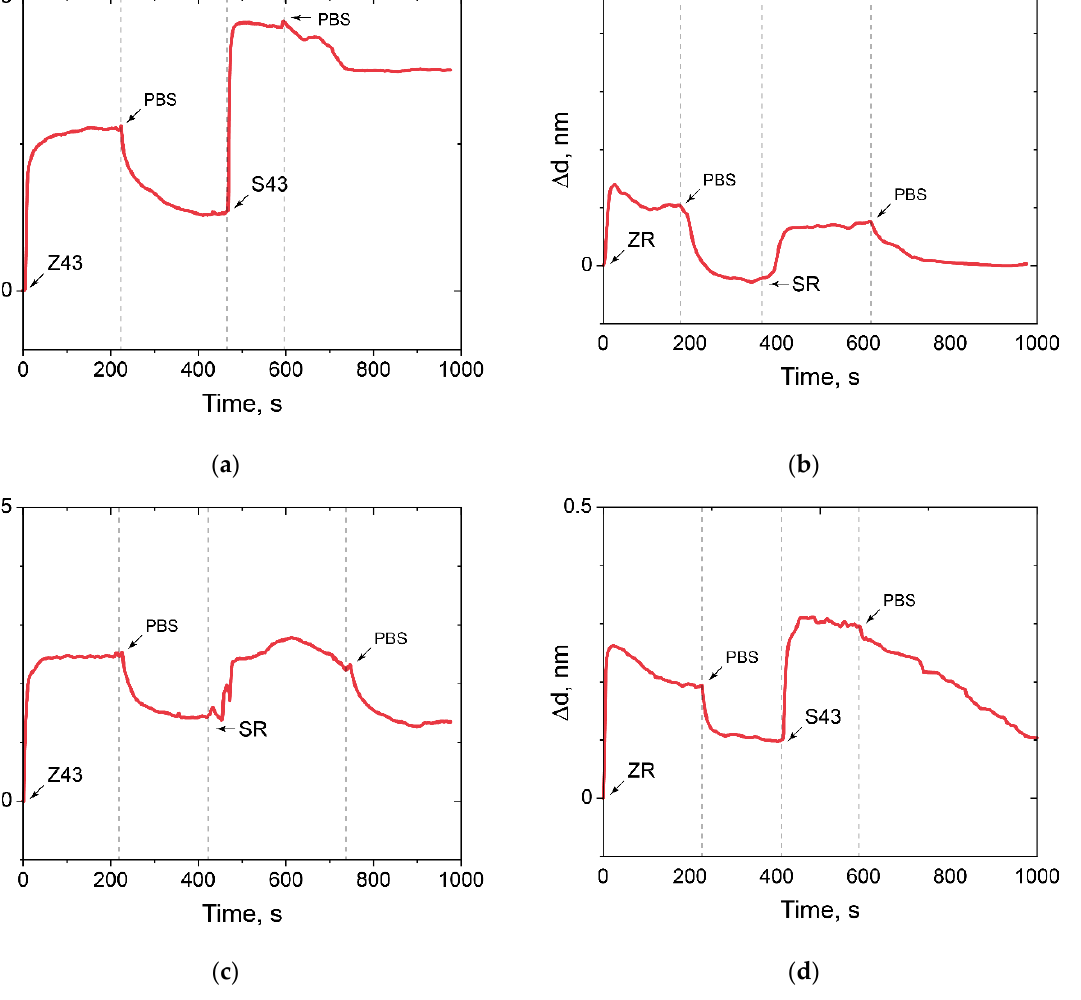
Figure 10. The change in the adlayer thickness upon positive and negative control of oligonucleotide hybridization. ( a ) Z43 is oligosensor, S43 is oligotarget; ( b ) ZR is oligosensor, SR is oligotarget; ( c ) ZR is oligosensor, S43 is oligotarget; ( d ) Z43 is oligosensor, SR is oligotarget. Thus, the possibility of solving an important problem [51,52] of low molecular weight oligonucleotides in picomole quantities detecting on the ED-modified PC chip by the PC SM method was demonstrated.